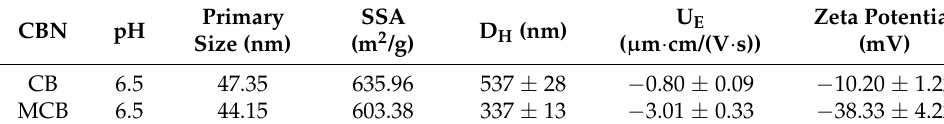
Table 1. Physiochemical properties of CBN powder and suspension.